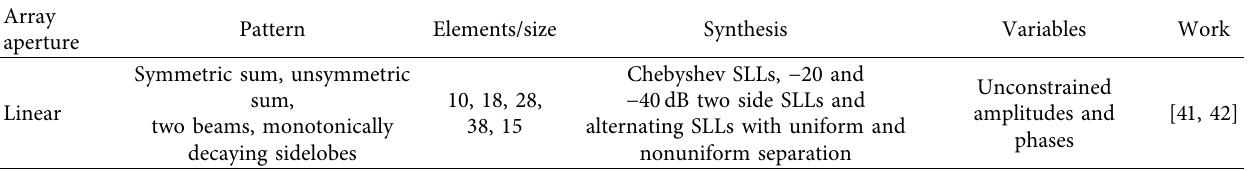
Table 3: The matrix inversion synthesis method: applications and features.